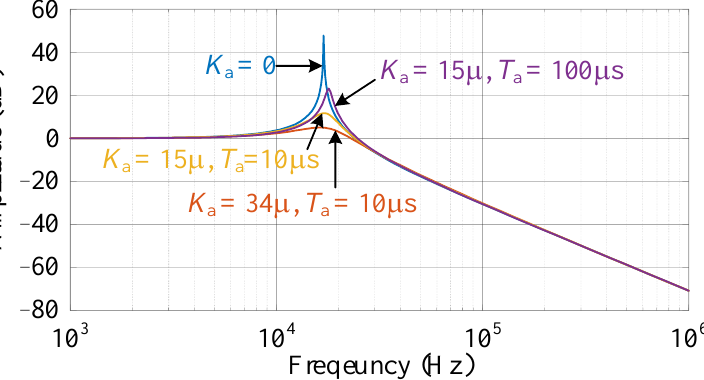
Figure 6. Grid currents considering the inaccurate reference of injected harmonic current: ( a ) 0% inaccuracy; ( b ) − 0.5% inaccuracy; and ( c ) 0.5% inaccuracy. Distortion is indicated with circles.